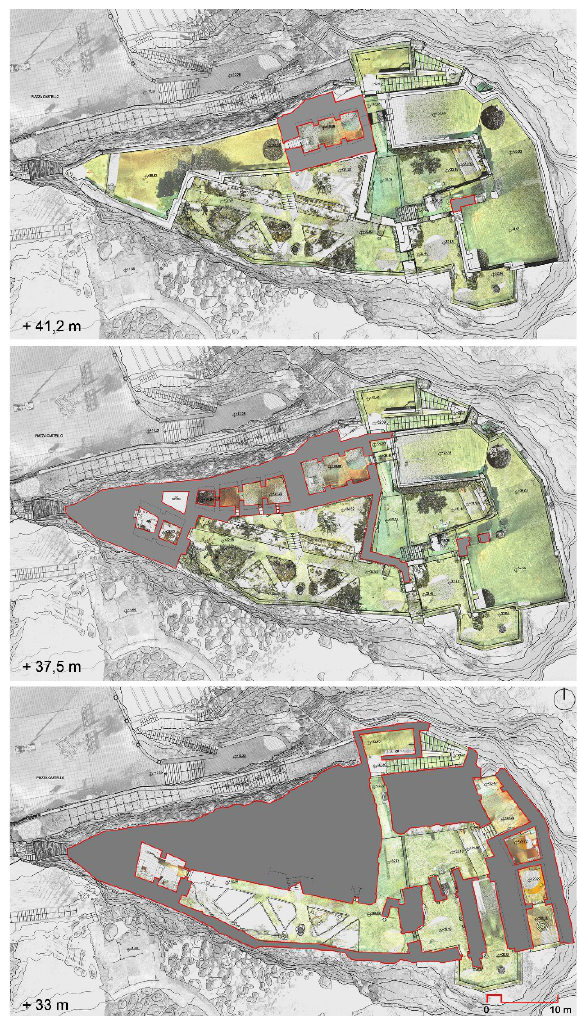
Figure 5: Aci castle, horizontal sections at different